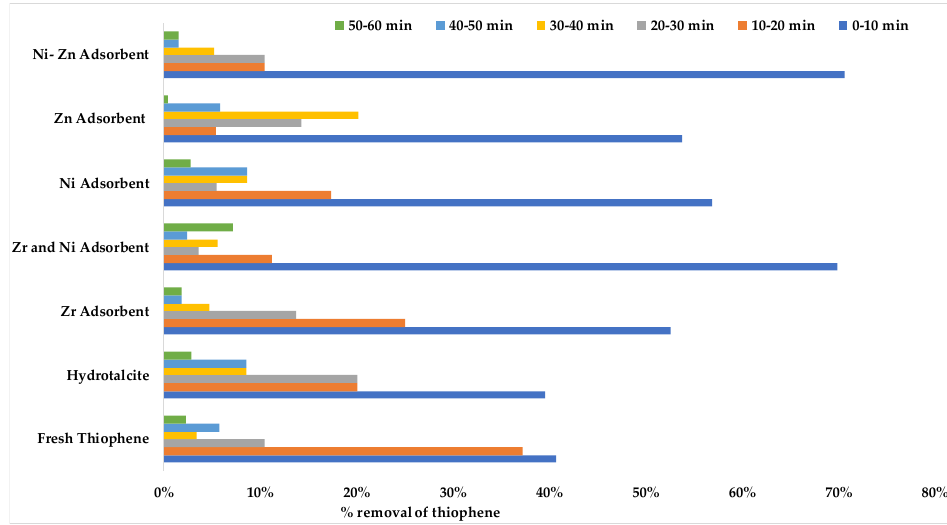
Figure 8. Percent removal of thiophene with respect to different time interval.